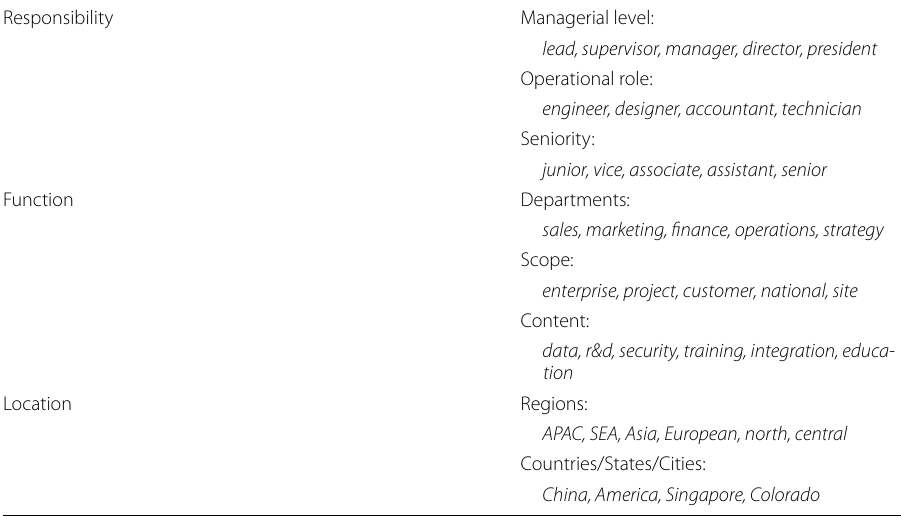
Table 2 Examples of occupational NE tags. Modified from [10]